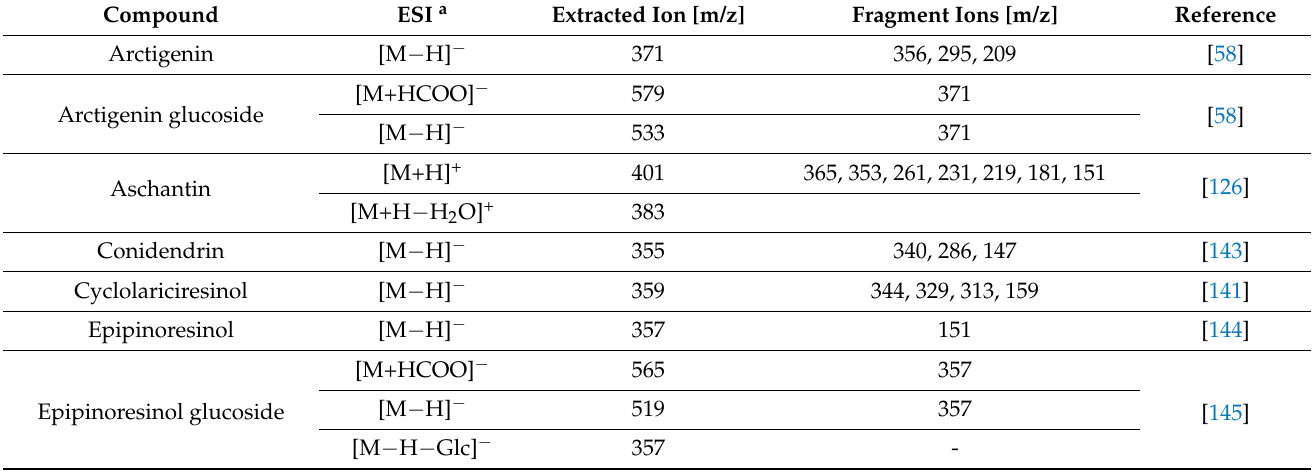
Table 3. MS fragmentation patterns of major